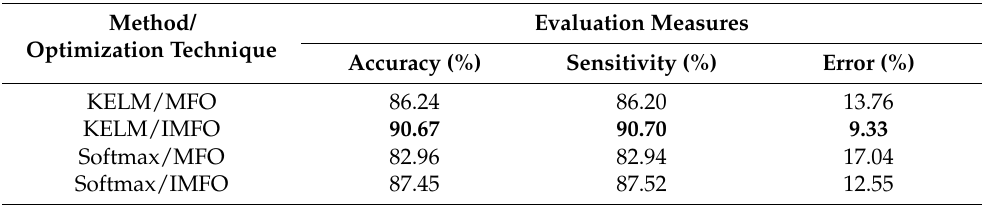
Table 11. Comparison of the proposed improved MFO with original MFO. Best values are shown in